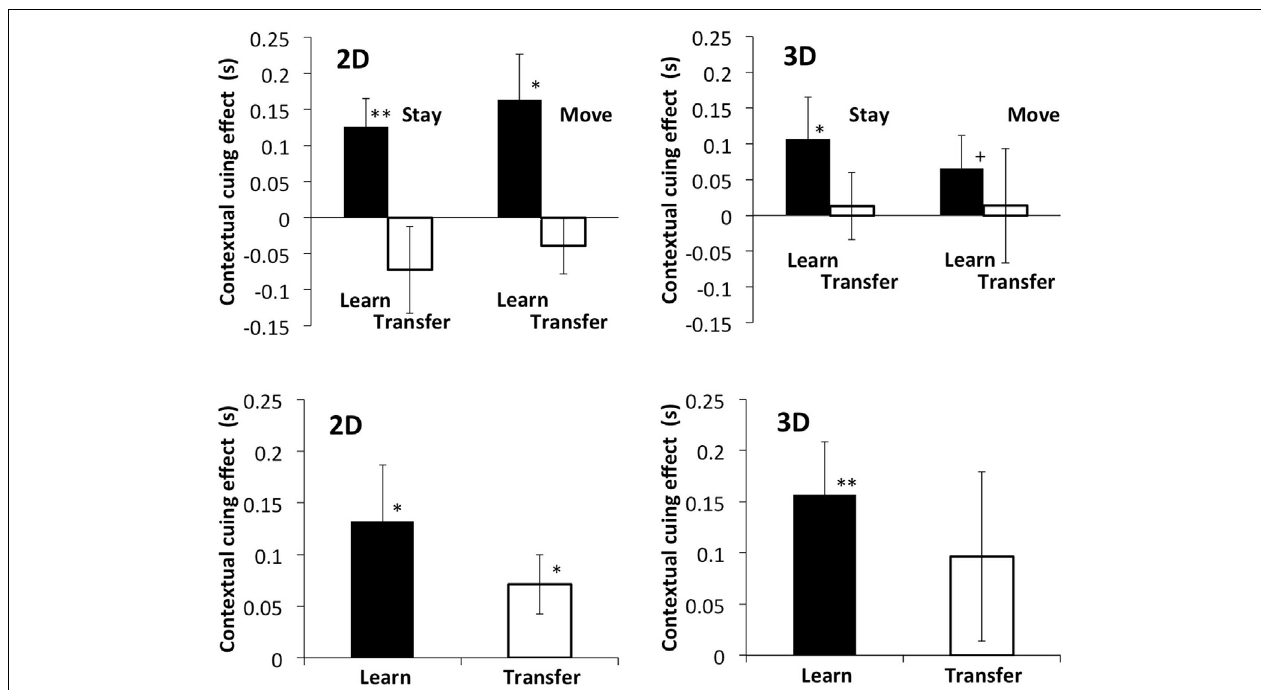
difference in reaction time between the novel and repeated configurations. The black bar shows the result of the last two epochs of the learning phase, and the white bar shows the result of the epochs of the transfer phase. Error bars represent standard error across participants.